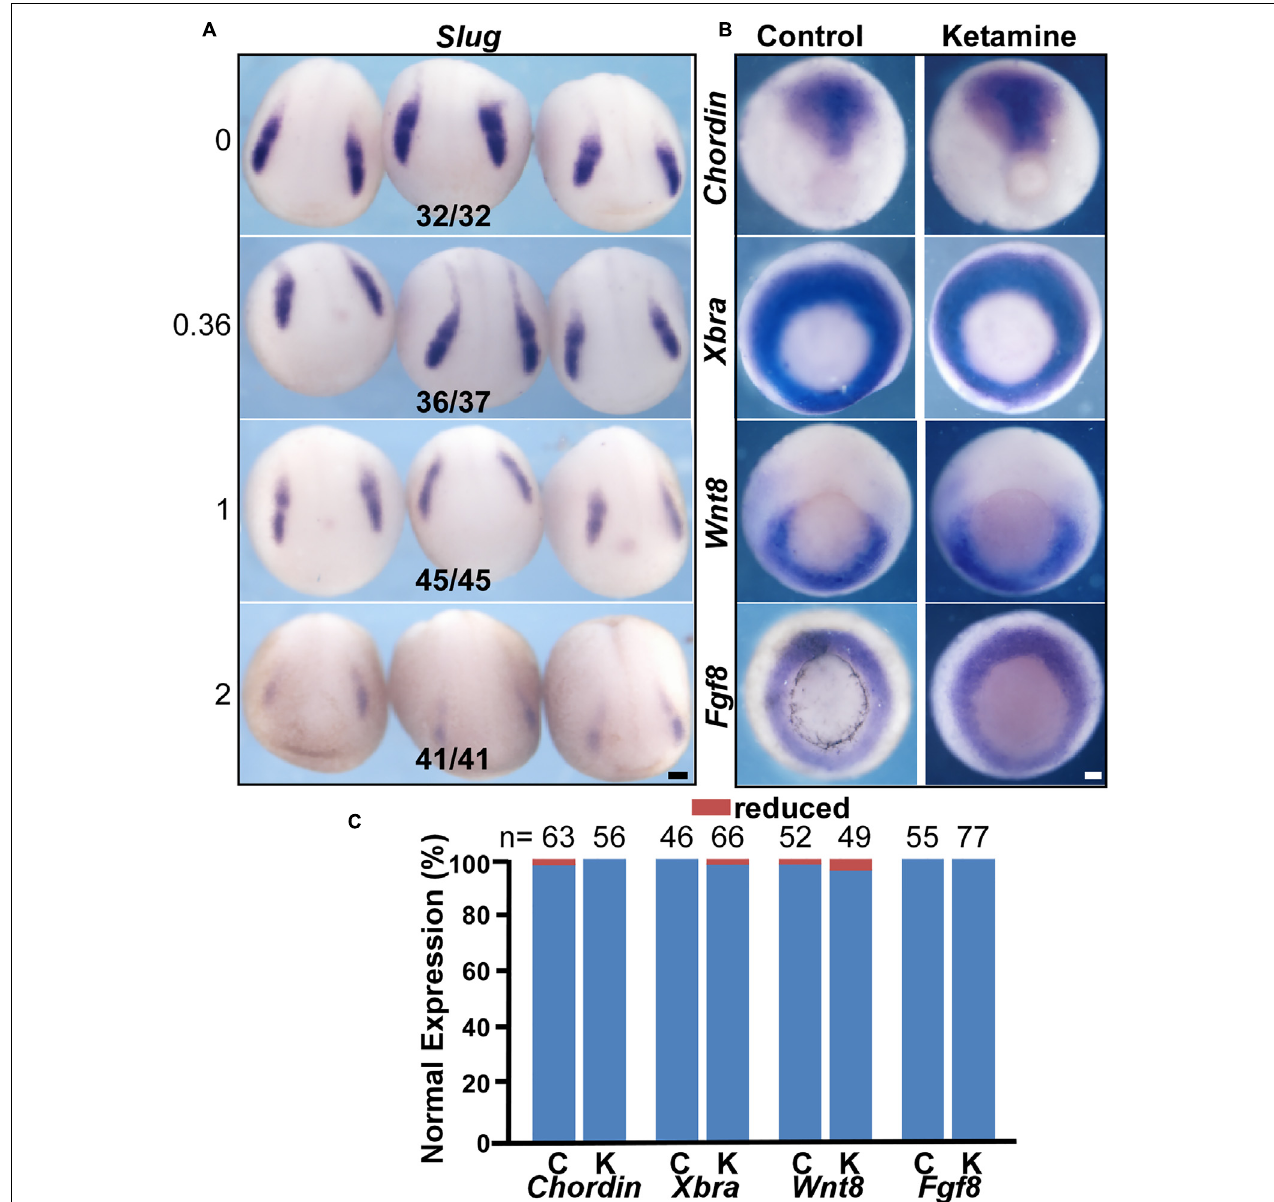
FIGURE 2 | Ketamine blocks NC induction independent of mesoderm genesis. (A) The expression of the NC marker gene Slug was inhibited by ketamine in a dose-dependent manner. The numbers of embryos showing similar changes in gene expression and total embryos in each concentration group are indicated. (B) Early mesoderm development is not affected upon ketamine exposure. There were no significant differences in the expression pattern of mesoderm marker genes chordin , Xbra , Wnt8 , and Fgf8 between control and ketamine-treated group prior to NC induction. (C) Quantitative analysis of gene expression patterns between control and ketamine group. Scale bar: 100 µ